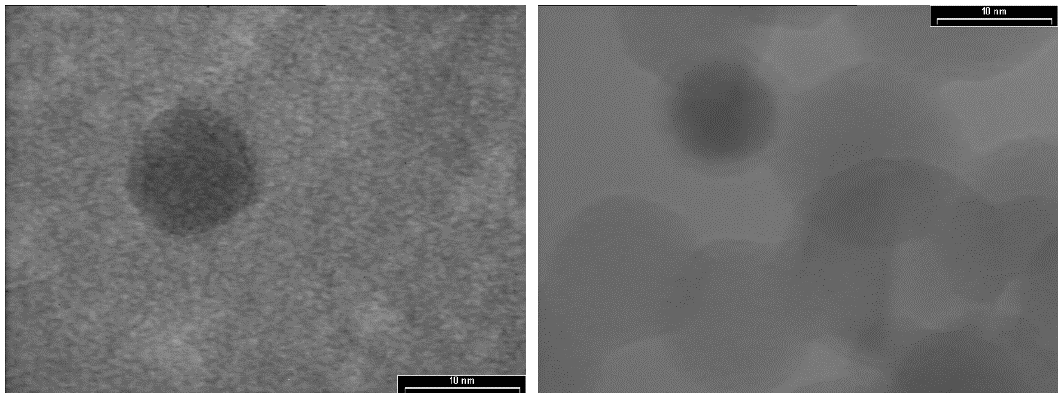
Figure 2. X-ray diffraction (XRD)pattern performed on the synthesized quantum dots (QDs). Figure 2. X-ray di ff raction (XRD)pattern performed on the synthesized quantum dots (QDs).